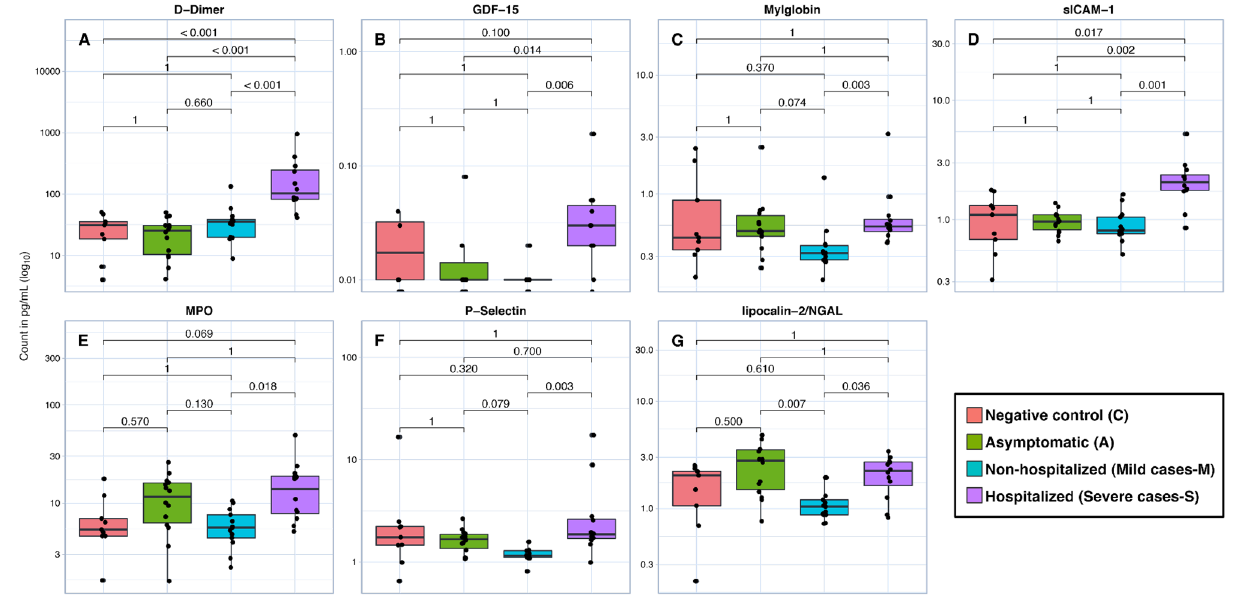
Figure 2. Box plot representation of serum concentration (pg/mL) of cardiovascular biomarkers. Levels of D-Dimer ( A ), GDF-15 ( B ), Mylglobin ( C ), sICAM-1 ( D ), MPO ( E ), P-Selectin ( F ), and Lipocalin-2/NGAL ( G ). The top and bottom lines of boxes are the 25th and 75th percentiles, respectively, and the band in the middle of the box is the median. Statistical analysis was performed using the Mann–Whitney U test between the negative control (C), asymptomatic (A), nonhospitalized (mild cases-M), and hospitalized (severe cases-S) groups.